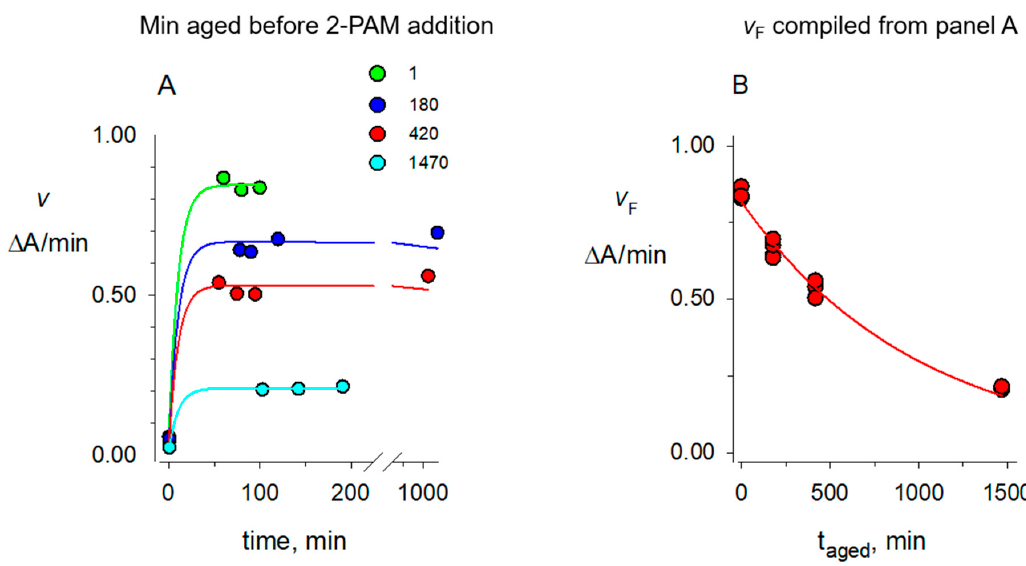
Figure 3. Aging of dimethylphosphorylated AChE in H 2 O. A mixture of 2.4 µ M paraoxon methyl (OP) and 0.5 µ M AChE in 100 mM sodium phosphate and 0.1% BSA (pH 8.0) was incubated for 60 min